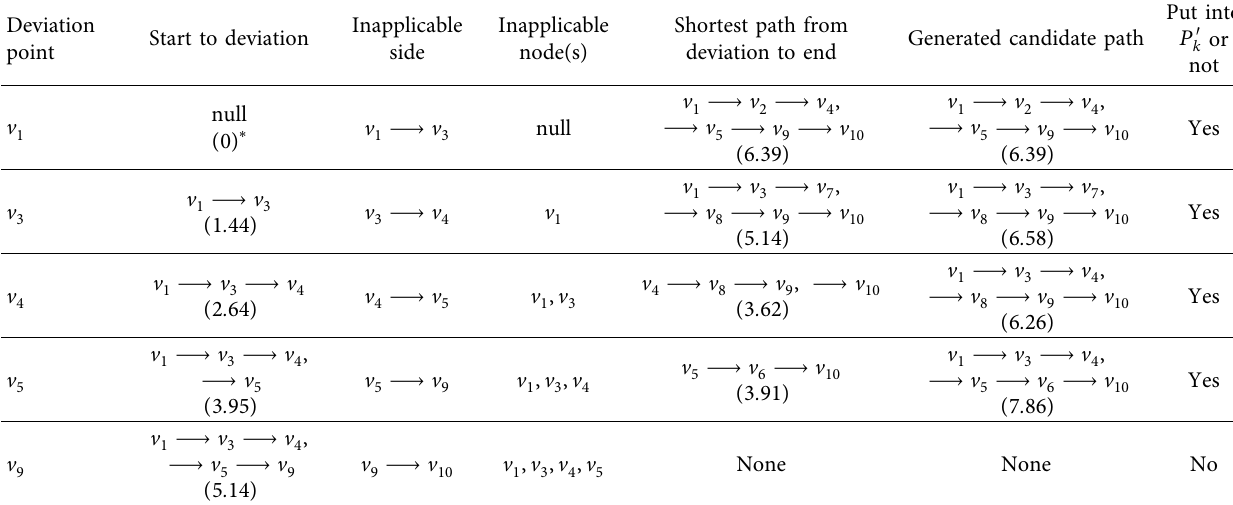
∗ The numbers in the brackets of the table indicate the accident risk.